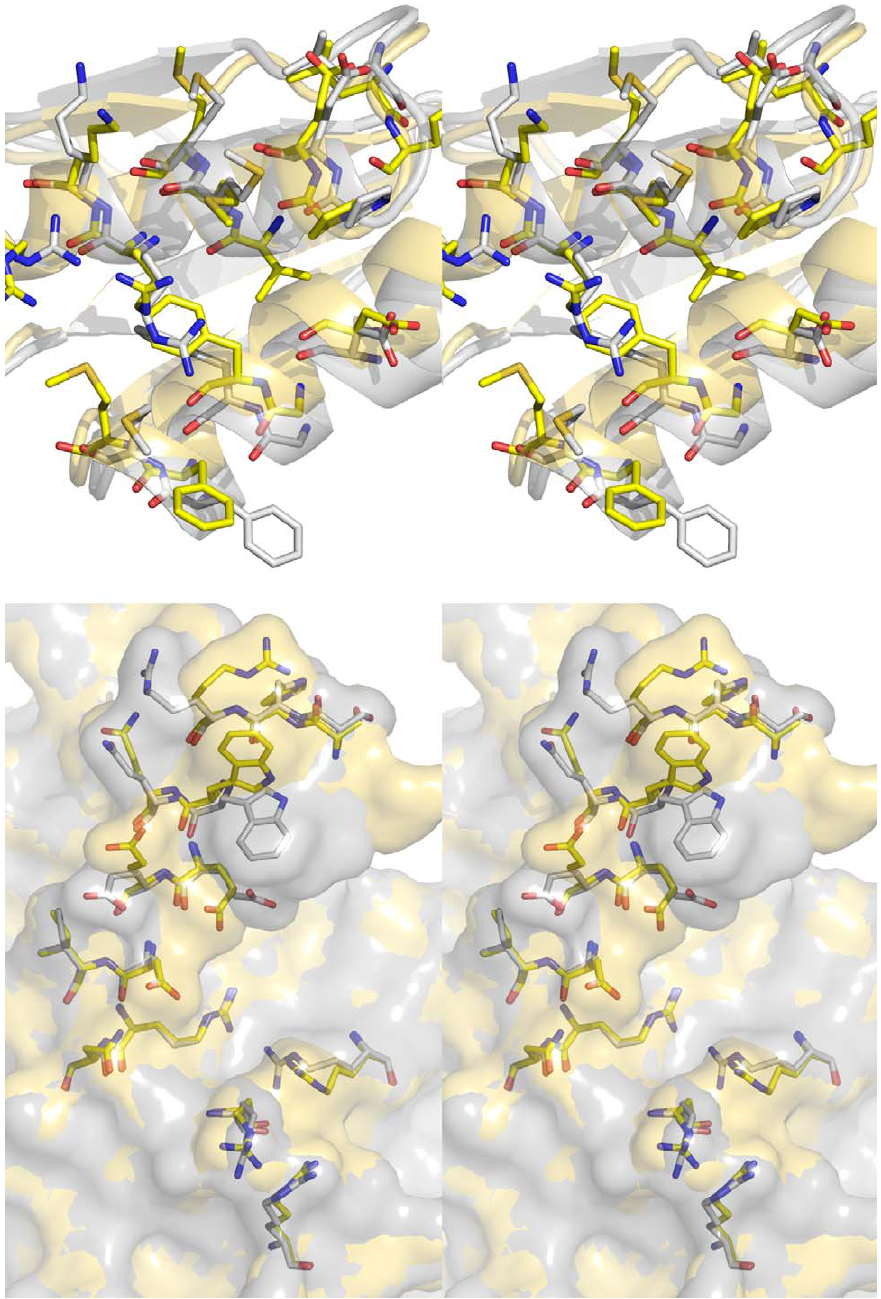
Figure 5. Split open IscS-TusA interface (gray) with superposed uncomplexed proteins (yellow). Above, TusA with secondary structure elements; below, IscS with semitransparent molecular surface. The reorientation of multiple sidechains creates better shape complementarity between the contacting molecular surfaces.